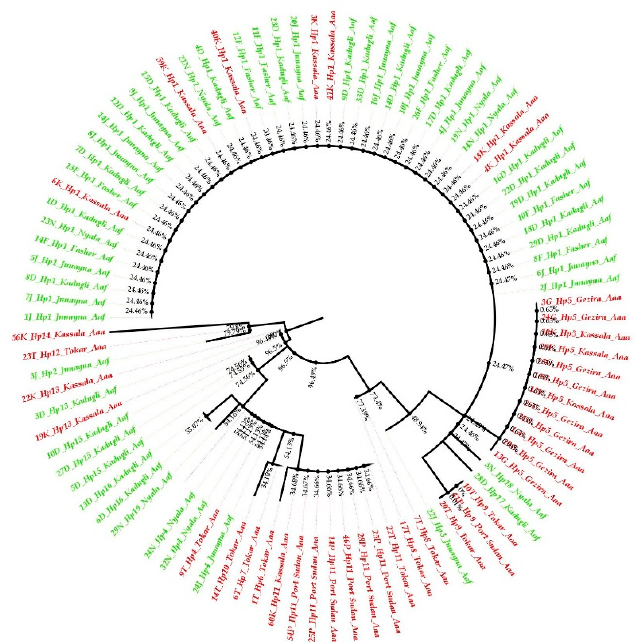
Figure 4. Polar maximum likelihood phylogenetic tree from 91 ND4 mitochondrial gene sequences from eight Aedes aegypti subspecies populations in Sudan. Aaa (red color), while Aaf (green color).